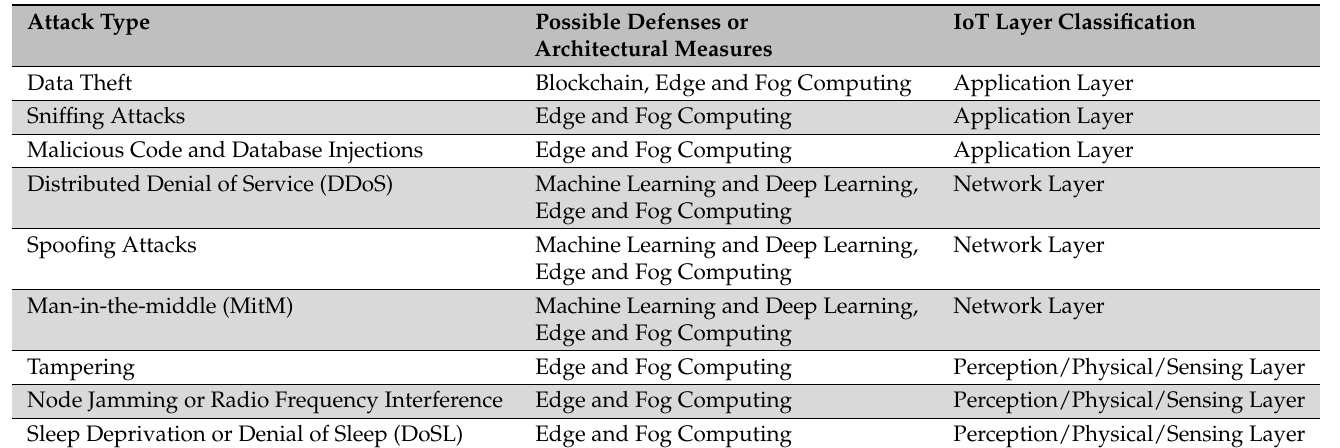
Table 1. Classification of Attack Types and possible Defenses or Architectural Measures in Urban IoT